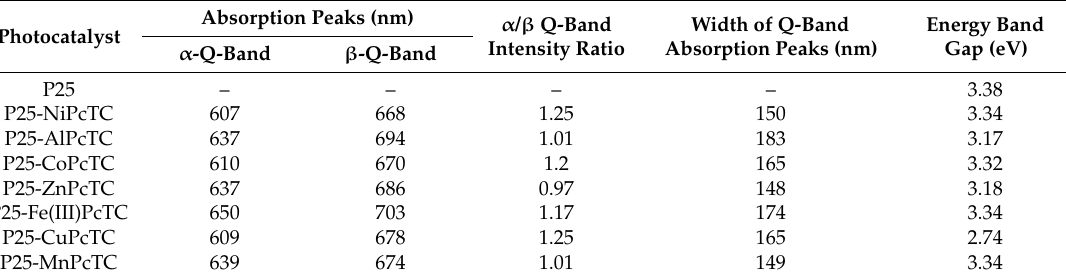
Table 2. Absorption data and band gap of the